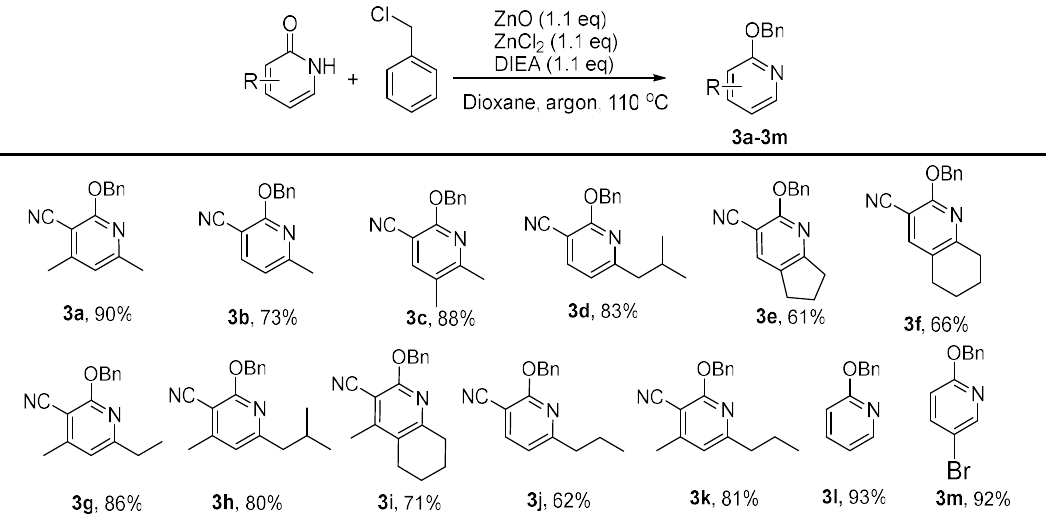
Table 2. Scope with respect to O -benzylation of substituted 2-oxo-1,2-dihydropyridines with benzyl chloride 1 .